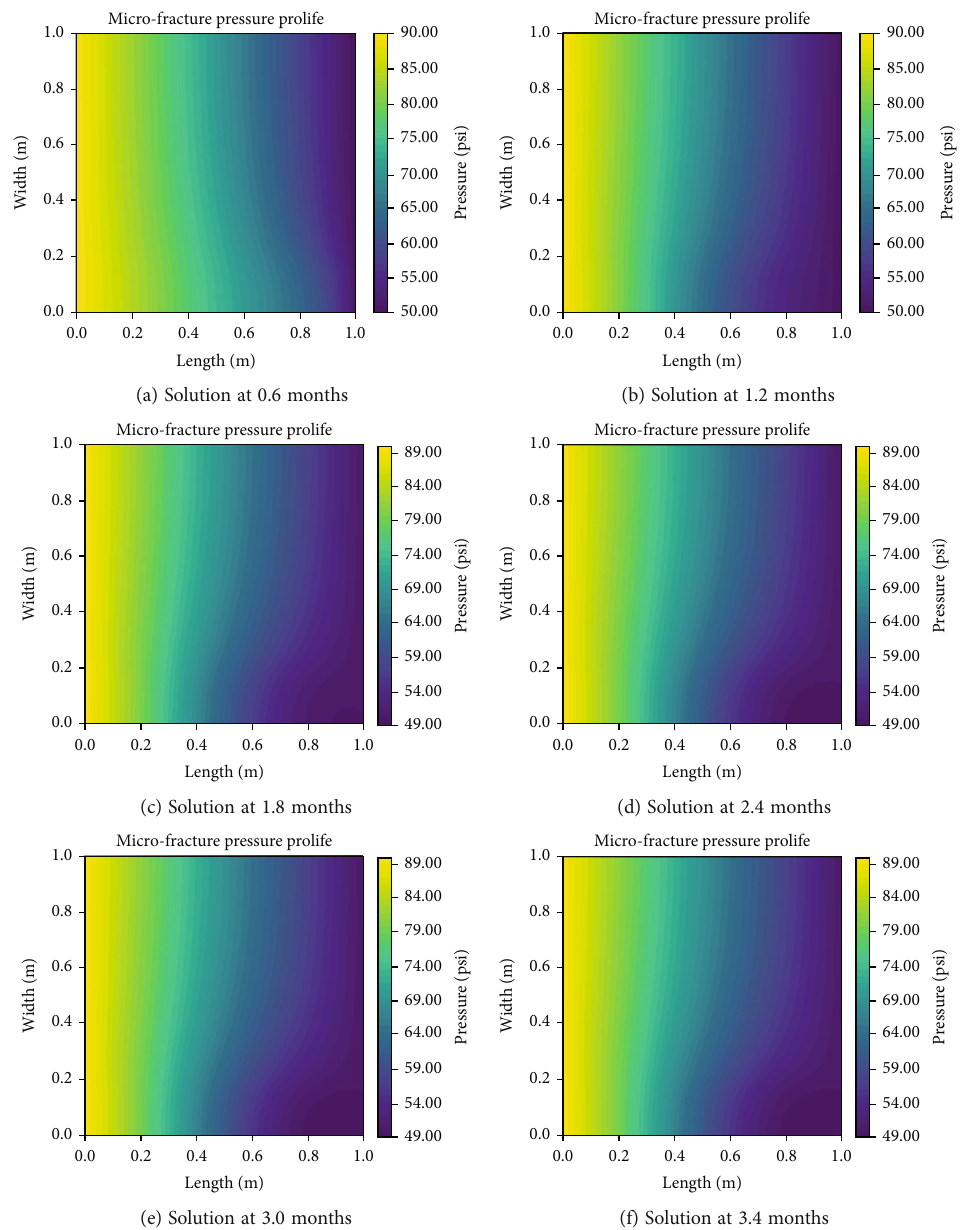
Figure 5: Pressure distribution in the microfracture domain with increasing time. A quasi-steady state regime observed after 2.4-month